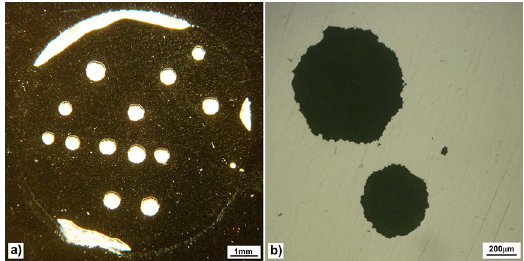
Figure 4. Optical micrographs from the corroded region on the untreated SMSS substrate highlighting: (a) the whole area and (b) corrosion pits at 50x of magnification